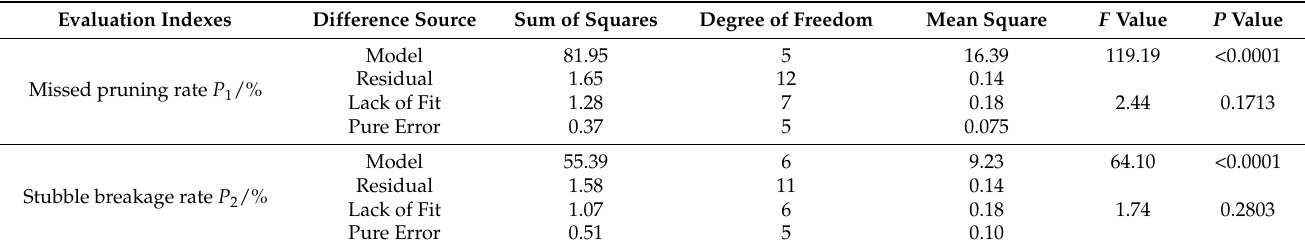
Table 5. Variance analysis table of regression models.